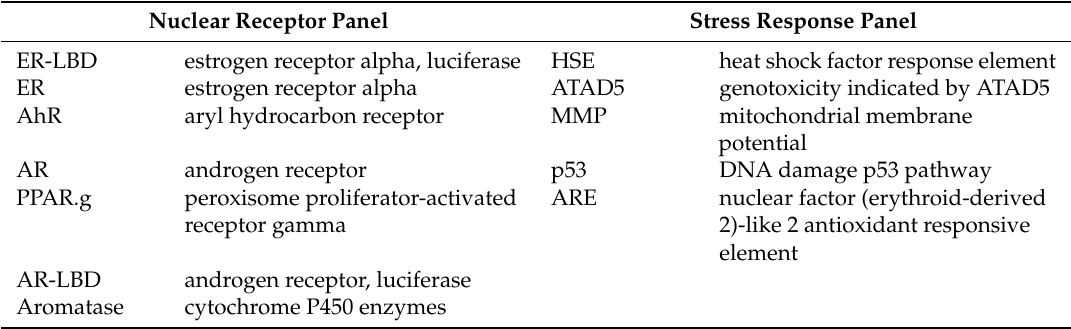
Table 1. Content of 12 properties. The left side are the seven toxic properties of the nuclear receptor e ff ects (NR), and the right side are the five toxic properties of the heat stress response e ff ects (SR).